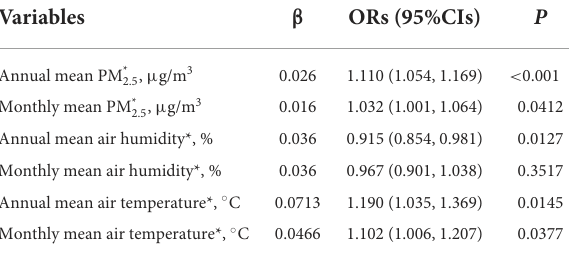
TABLE 2 PM 2.5 , air temperature, and humidity in the allergic rhinitis and non-rhinitis groups.